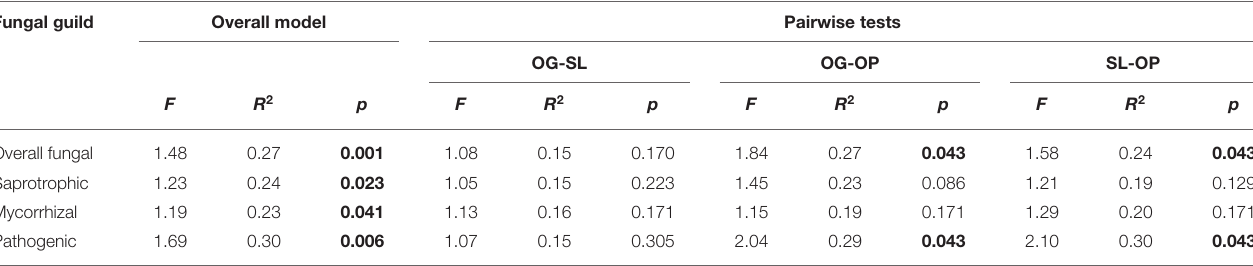
TABLE 1 | PERMANOVA test statistics for differences in fungal guild community dissimilarities by land-use types of old-growth (OG) and selectively logged (SL) lowland dipterocarp rainforest and oil palm plantation (OP) in Sabah, Borneo. Fungal guild